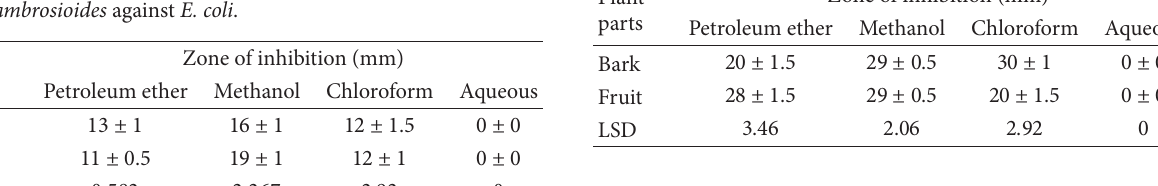
Table 6: Zone of inhibition produced by extracts of different parts